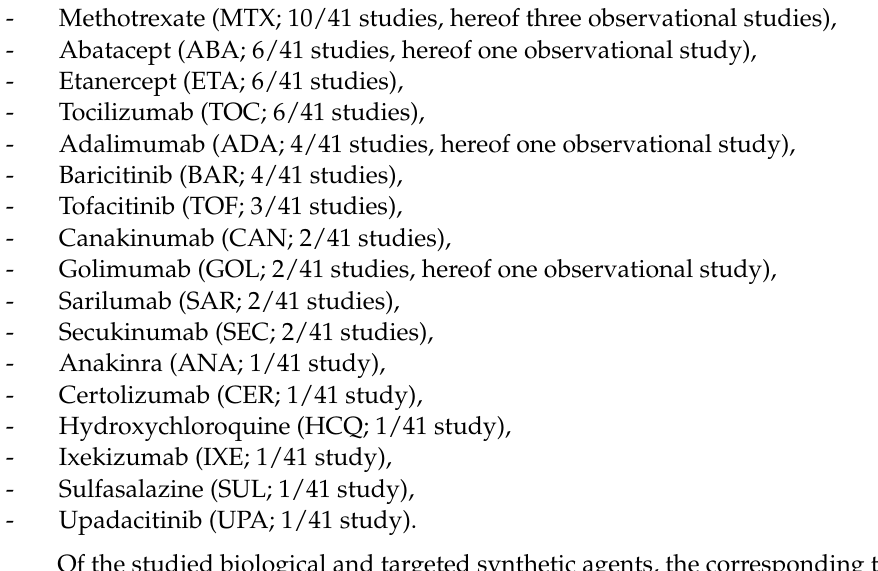
Figure 2. Proportions of DMARD agents involved in registered studies.